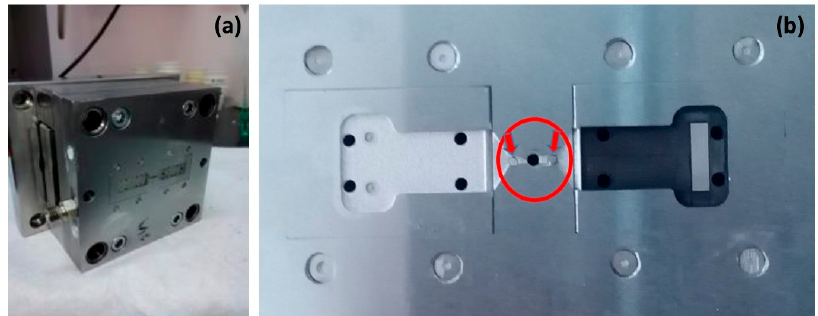
Figure 1. ( a ) Picture of the mold; ( b ) Overview of the mold inserts for the production of the plates, where the interchangeable pins are highlighted.